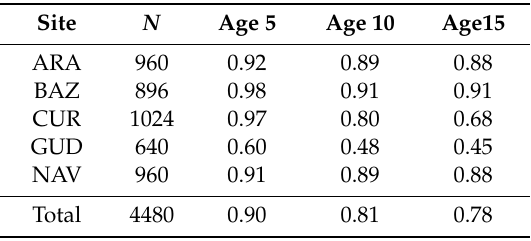
Table 4. Survival rates at five Scots pine trial sites in Spain along 15 years after planting.